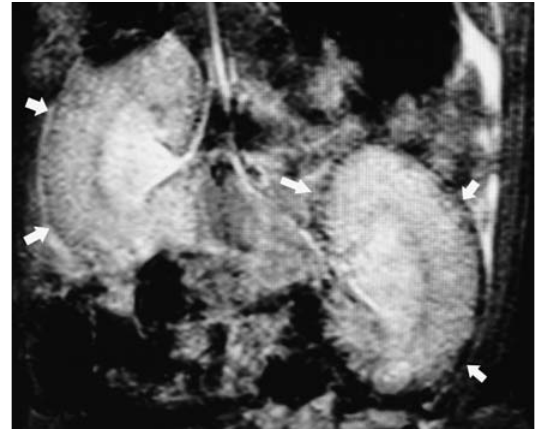
Coronal T2*-weighted MR image of the rat kidney obtained 1 h after injection with the labelled mesenchymal stem cells (MSCs) shows a signal intensity decrease (arrows) in the outer zone of the renal